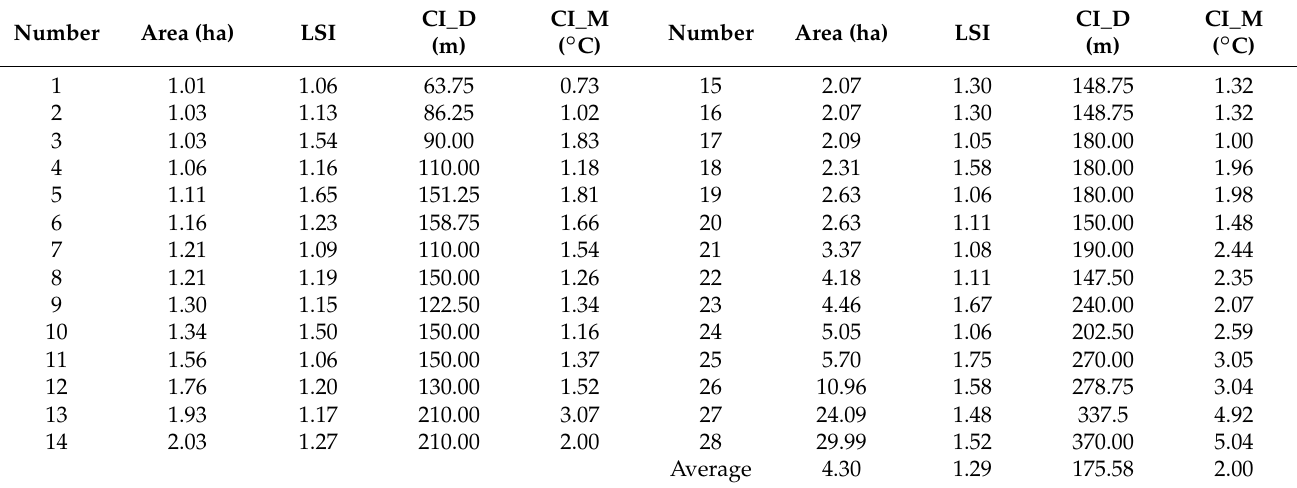
Table A2. Average cooling effect of blue